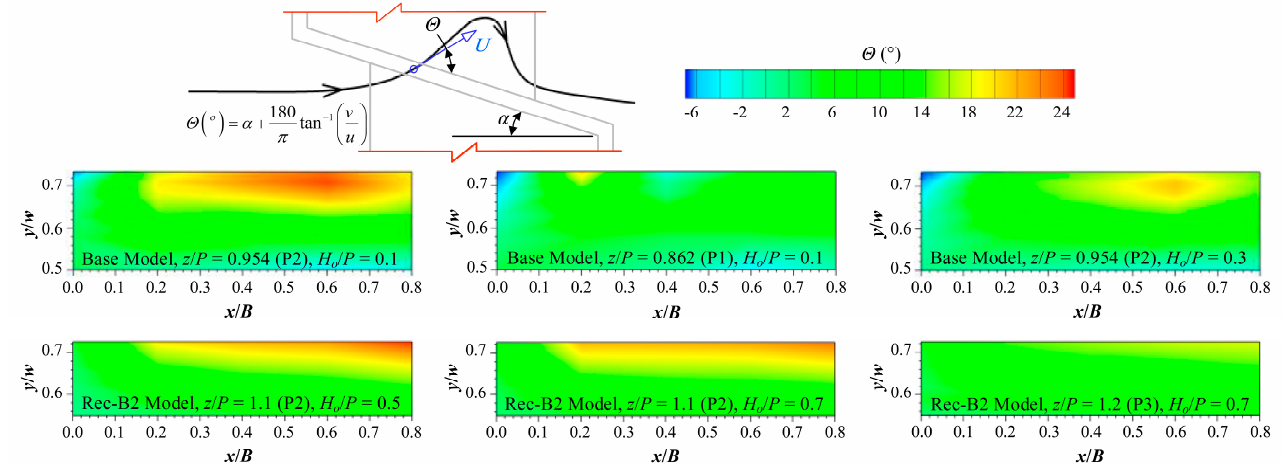
Figure 12. Contours of Θ for the base model (upper figures) and the Rec-B2 model (lower figures).